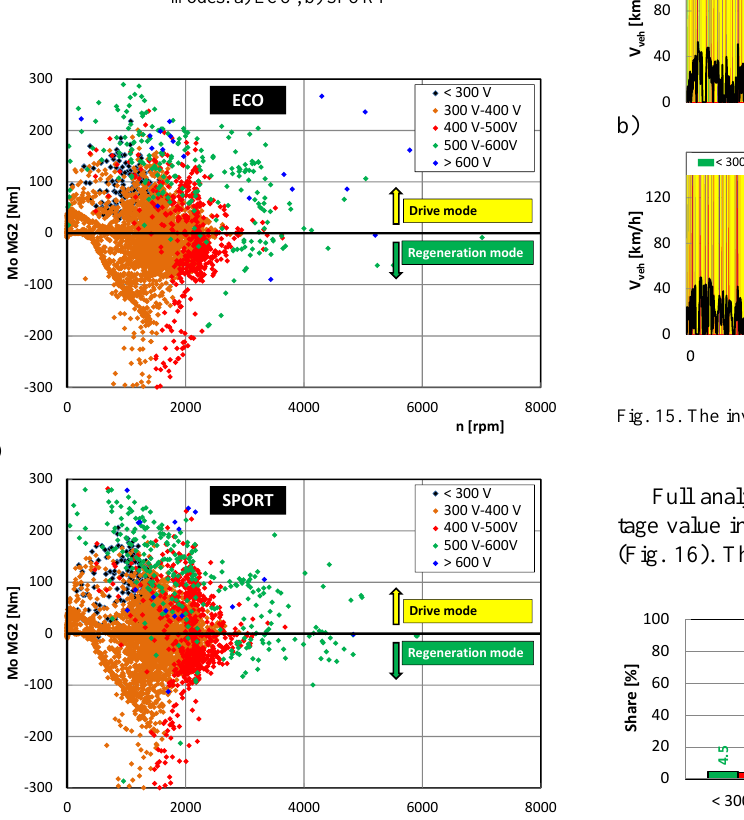
Fig. 16. Percentage shares of inverter voltage ranges in the RDE test conditions for the two driving